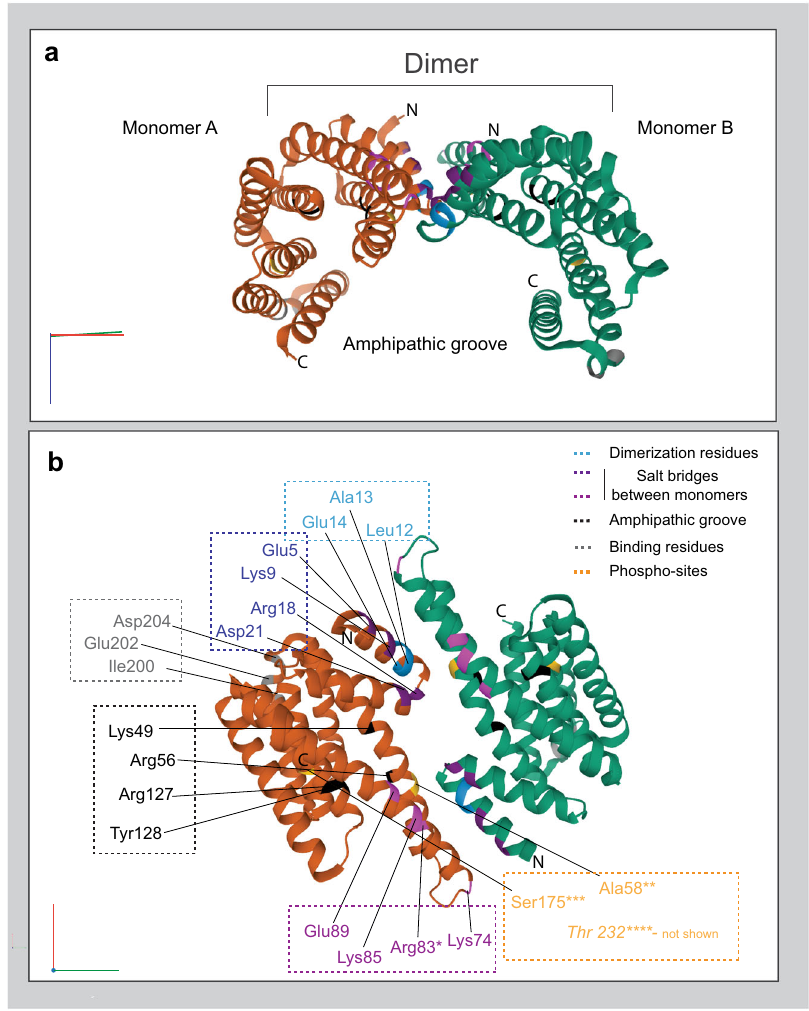
Fig. 1 Structure of 14-3-3. Orthogonal views of human 14-3-3 θ / τ , modi fi ed from 6BD1 226 . a Schematic representation of the main structure of human 14-3-3 θ / τ showing the spatial allocation of the amphipathic groove. b Some of the most signi fi cant residues involved in structure stability and functionality. Some isoform-speci fi c mutations are depicted: Arg83* is replaced by Glu83 in the 14-3-3 σ isoform and involved in Lys9-Glu83 binding. Ala58** is present only in isoforms - θ / τ and - σ ; all the other isoforms present a Ser58 which is a very important phosphorylation site (see main text). Ser175*** indicated as Ser184/186 in the main text. C: C-terminal, N: